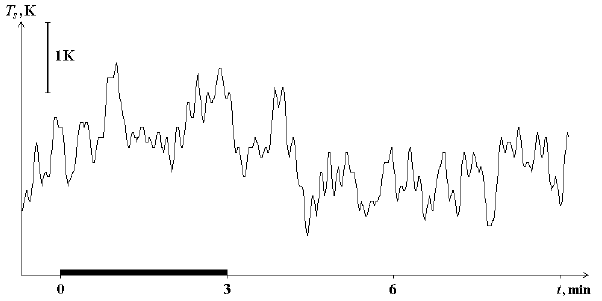
Fig. 4. The signal temperature T s at f = 606MHz versus time after the pump wave turn on, obtained on 24 August 2000 at 22:30– 22:50LT. The data are averaged over two successive pumping ses- sions with 3 min “on” and 7 min “off” periods at f 0 = 6 . 6MHz and 6.56MHz, β = 61 ◦